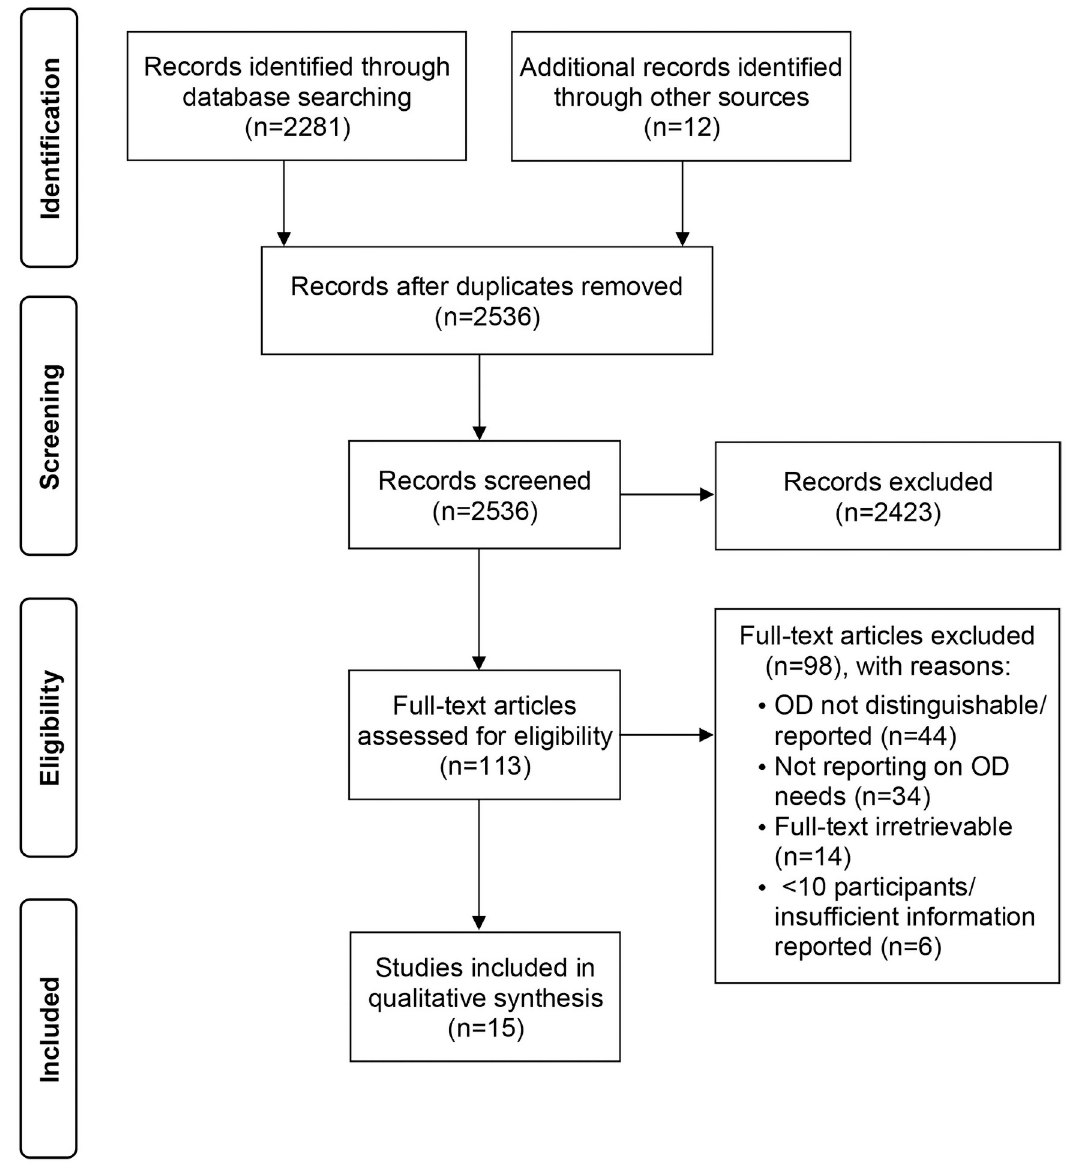
Fig 1. PRISMA flow diagram summarizing the study selection process. Adapted from Moher et al. [64].